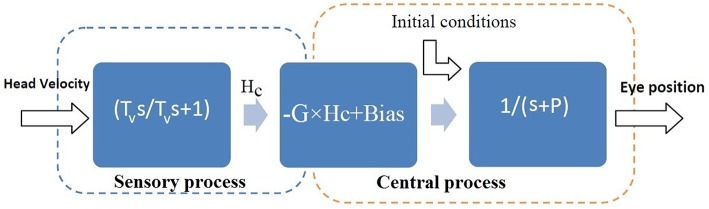
Assumed structure for the slow phase VOR: linear dynamics followed by a Hammerstein system (Jalaleddini and Kearney, 2013). Hv is head velocity (deg/s), Hc is the sensory signal (spikes/s) and E is conjugate eye position (deg). s refers to Laplace variable and Tv refers to the sensory time constant in the first block. G is the steady state gain and Bias is added to model the bias in VOR responses due to asymmetries in the second block. P refers to the pole of the central processing in the third block and the central processing time constant is: T=-1P, P<0.